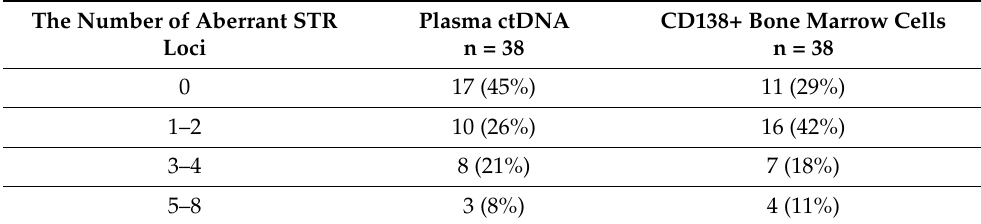
Table 2. Quantitative assessment of STR loci with LOH in plasma ctDNA and in CD138+ bone marrow cells of MM